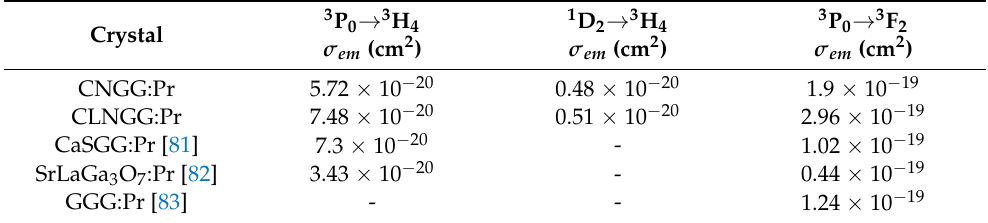
Figure 12. Emission spectra of Pr 3+ ions in CNGG:Pr and CLNGG:Pr crystals. (Reprinted with permission from Ref. [24], copyright 2019, Elsevier). Table 12. Calculated emission cross-sections ( σ em ) of Pr 3+ ions in CNGG:Pr and CLNGG:Pr in comparison with other Pr-doped crystals. (Reprinted with permission from Ref. [24], copyright 2019, Elsevier).